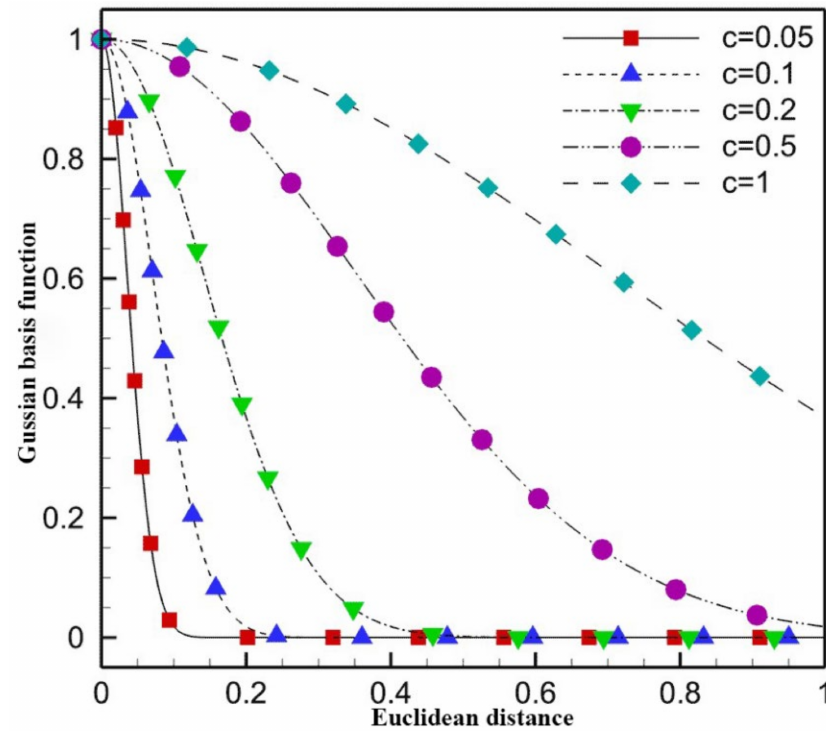
Figure 4. Gaussian basis functions corresponding to different shape